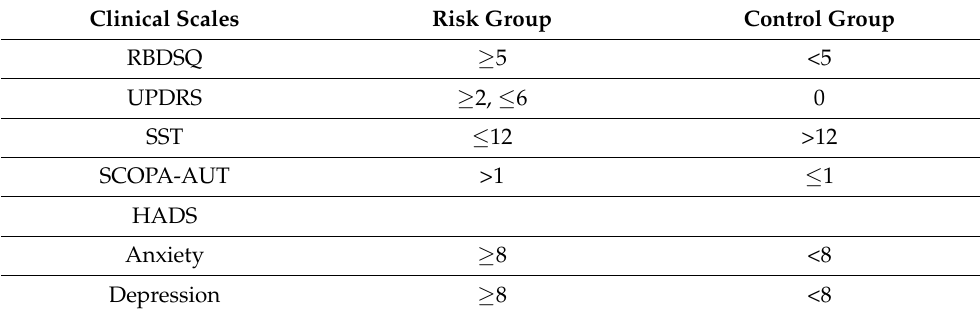
Table 4. Criteria for the inclusion of patients in the risk group and in the control